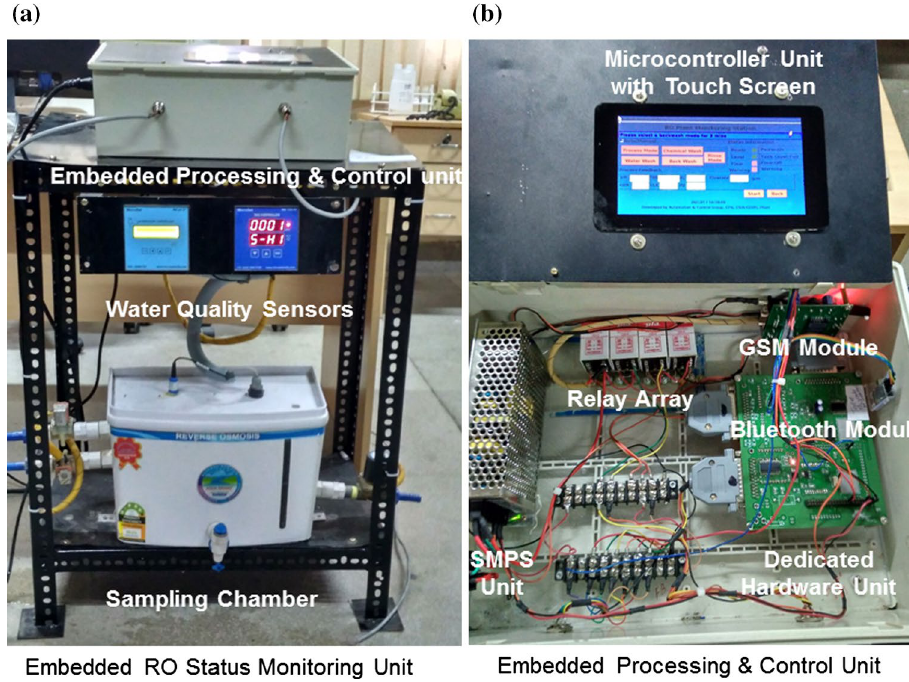
Fig. 3 a Deployed RO plant status monitoring unit and b developed embedded processing and control